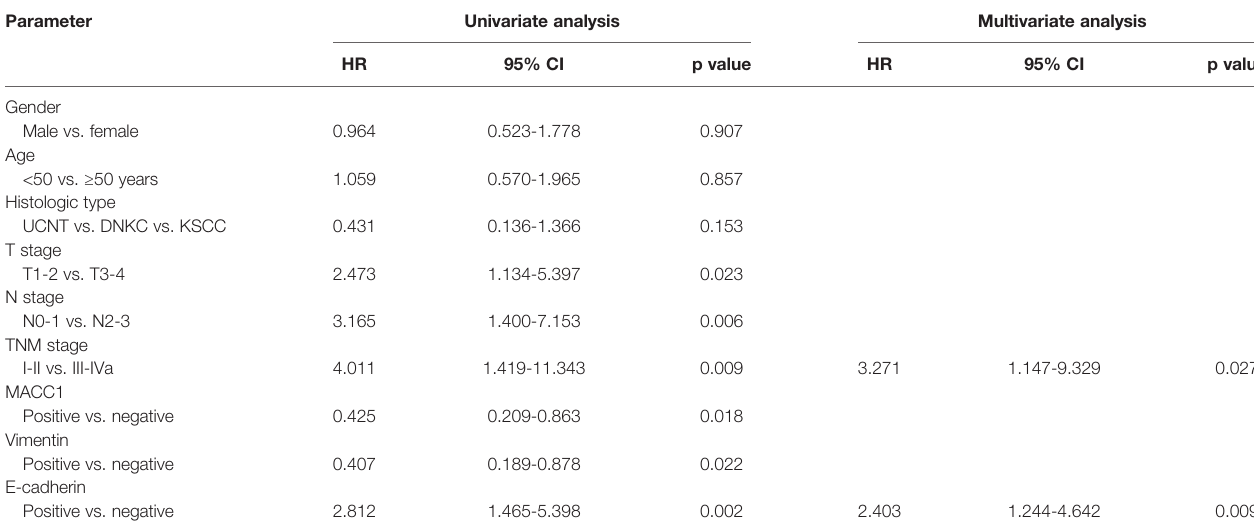
TABLE 5 | Univariate and multivariate analyses of prognostic factors for 5-year disease-free survival.